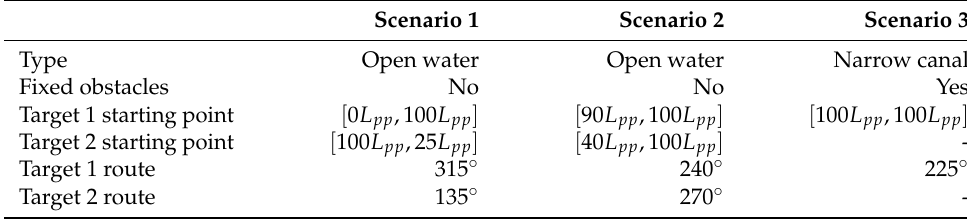
Table 1. Route and starting point of the targets in the simulated